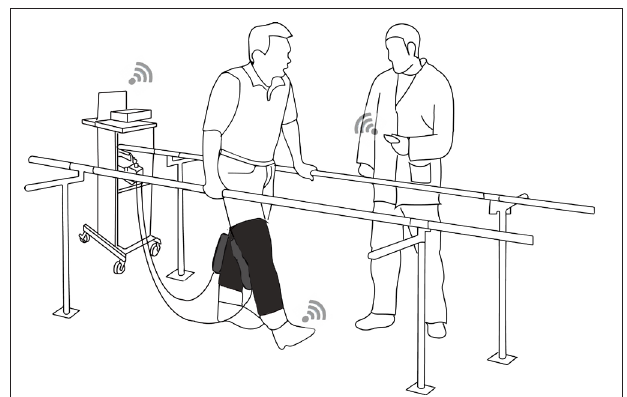
Figure 1 | 1 Illustration of the soft-inflatable exosuit and its utilization in a rehabilitation setting with the physical therapist wirelessly tuning the assistance provided by the exosuit to the user based on sensory outputs from the smart shoes and